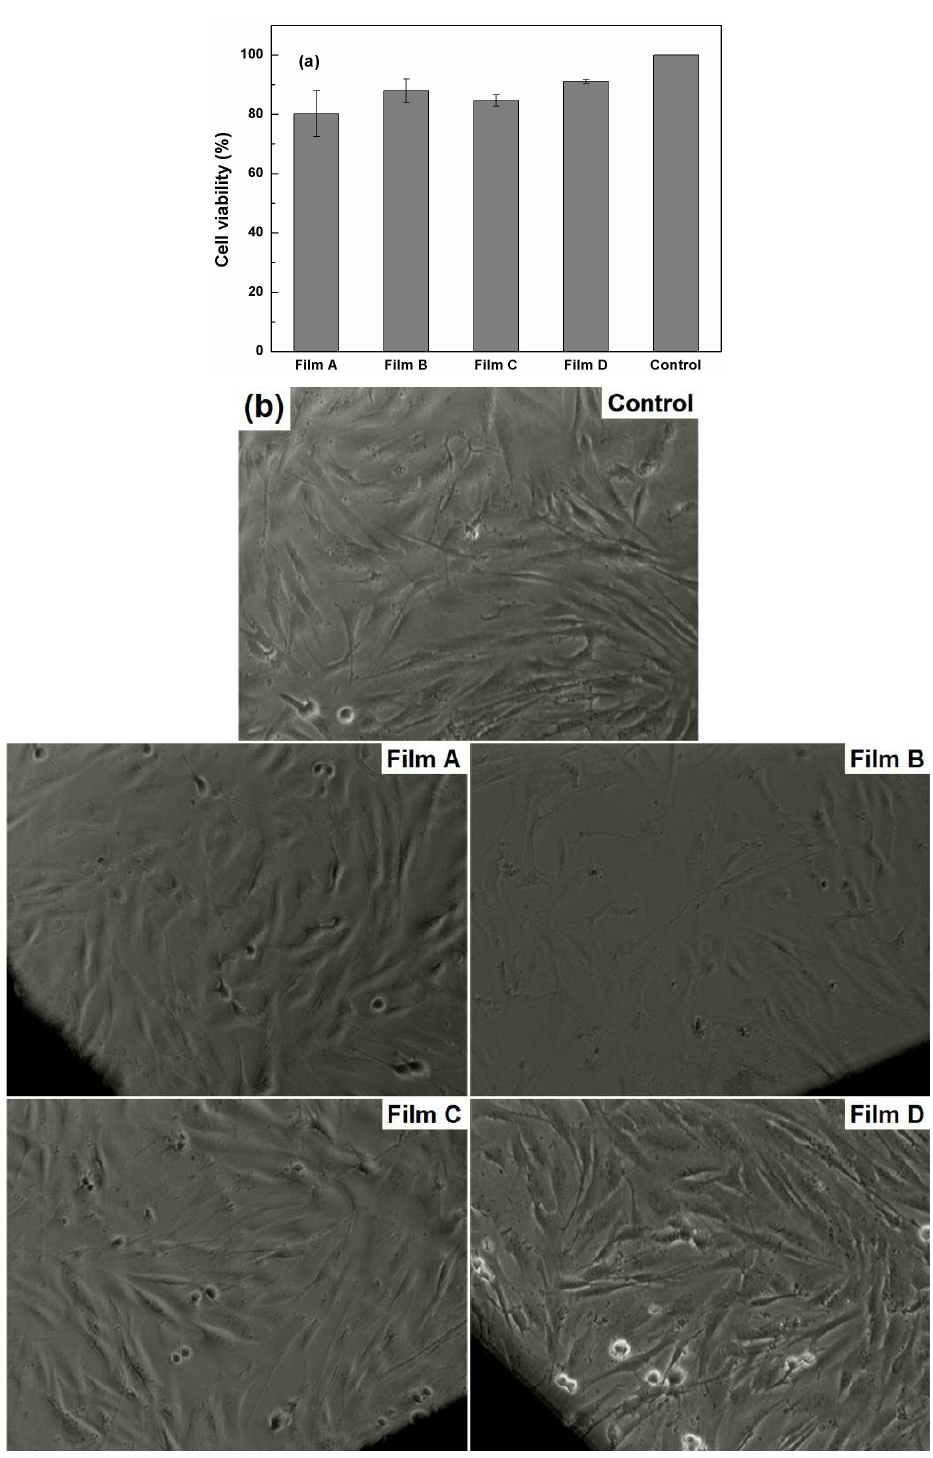
Figure 7. ( a ) Cell viability by MTT assay and ( b ) optical microscopy images (20× magnification) of BJ cells grown for 24 h in the presence/absence of the samples.